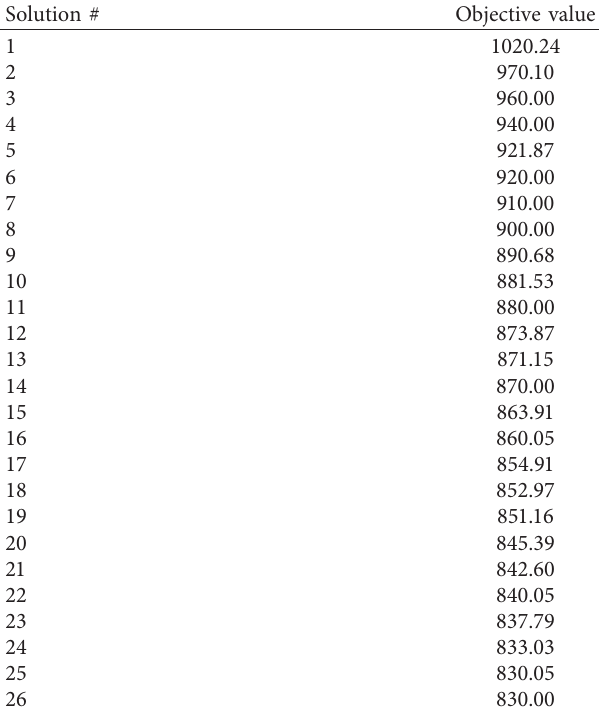
Table 6: Objective